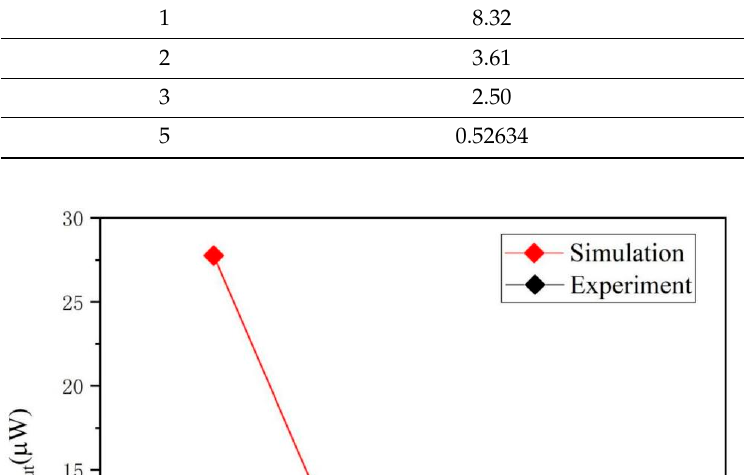
Table 1. The experimental and theoretical output power of output light as a function of the topological charge of vortex light at 780 nm, where the pump power at 1950 nm is 180 mW and the power at 780 nm is 6 mW. Figure 3. Light intensity distribution and phase distribution during propagation of the vortex opti- cal field. ( a , f , k , p ) Spiral phase diagrams of different topological charges loaded by spatial light mod- ulators. ( b , g , l , q ) are the theories that accurately model the lateral light field distributions carrying light fields of l = 5, 3, 2, 1. ( c , h , m , r , d , i , n , s ) represent the input and output light fields with topological charge L = 5, 3, 2, 1 ( c , h , m , r ) show the distribution of the input light fields. In addition, ( d , i , n , s ) represent the distribution of the output light fields). The lateral light field distribution maps of ( e , j , o , t ) are the lateral light field structures of the output light field after being compressed by a cylindrical lens carrying a 1300 nm laser with l = 5, 3, 2, 1. ( a , f , k , p , b , g , l , q ) are numerical simulation graphs, and ( c , h , m , r , d , i , n , s , e , j , o , t ) are experimental results.